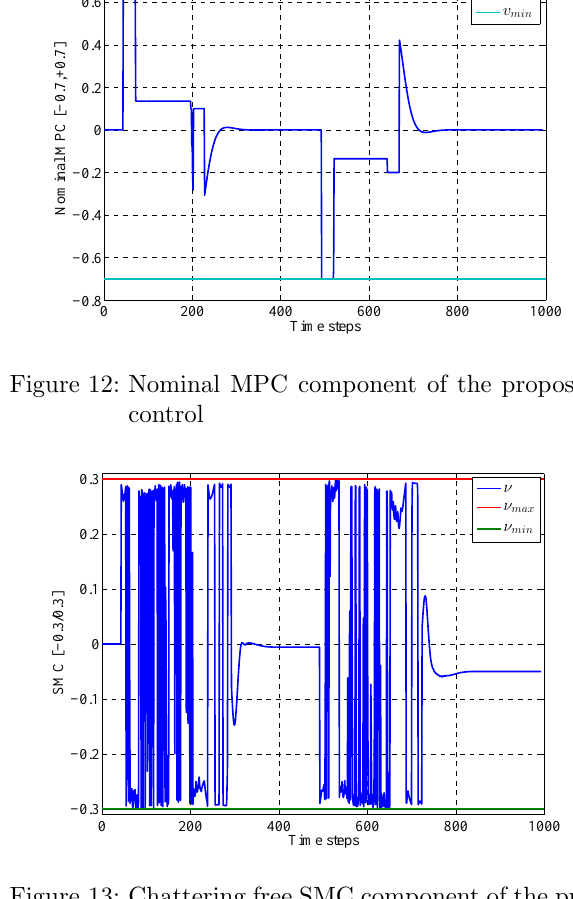
Figure 10: The angular position z 1 of the nominal model for the nominal MPC, and x 1 of the real plant for the proposed control